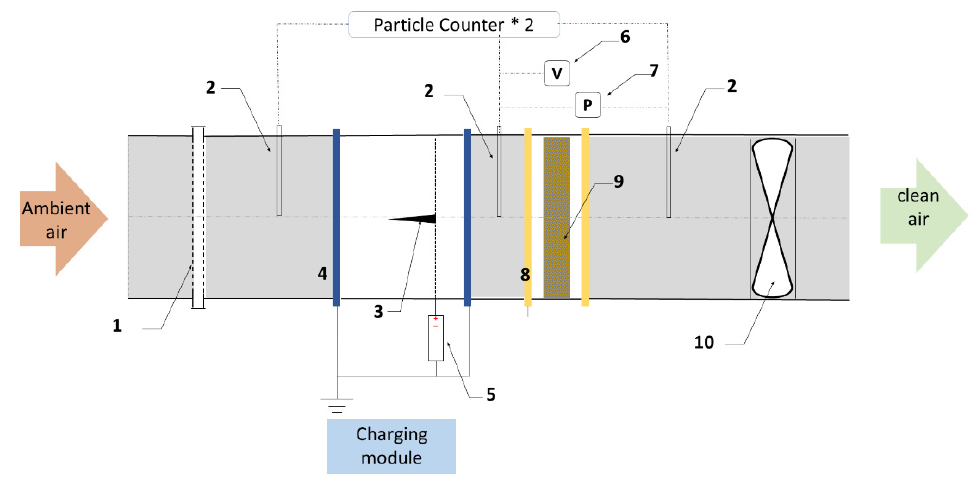
Figure 2. Schematic setup representation. 1. Diffusion plate, 2. Sampler, 3. Charging pins, 4. Metal rings, 5. HVDC power, 6. Anemometer, 7. Differential pressure sensor, 8. Metal mesh, 9. Membrane, 10. Fan and frequency converter.